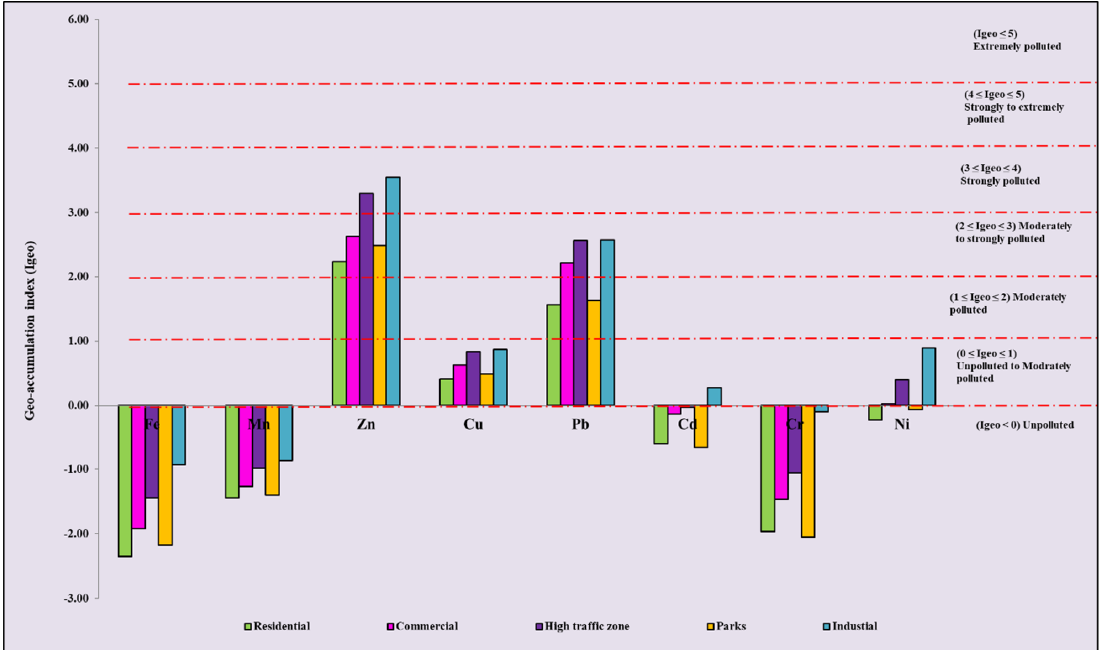
Figure 3. Geo-accumulation index (I geo ) of HMs in the road dust of Lucknow over different func- tional areas.